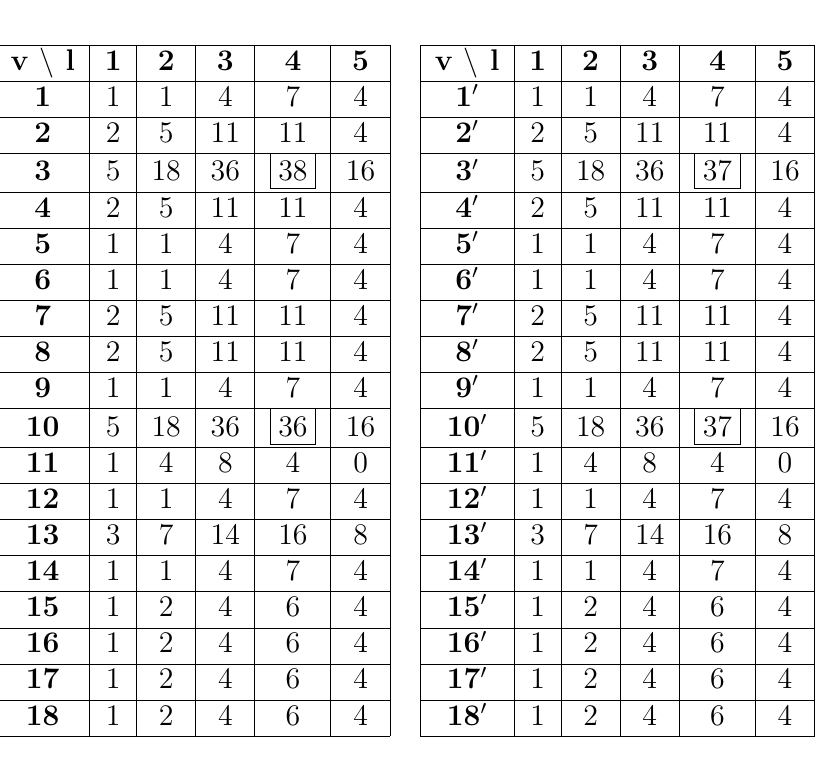
Table 2 : The vertex path-tables 𝑉 𝑃 ( 𝑇